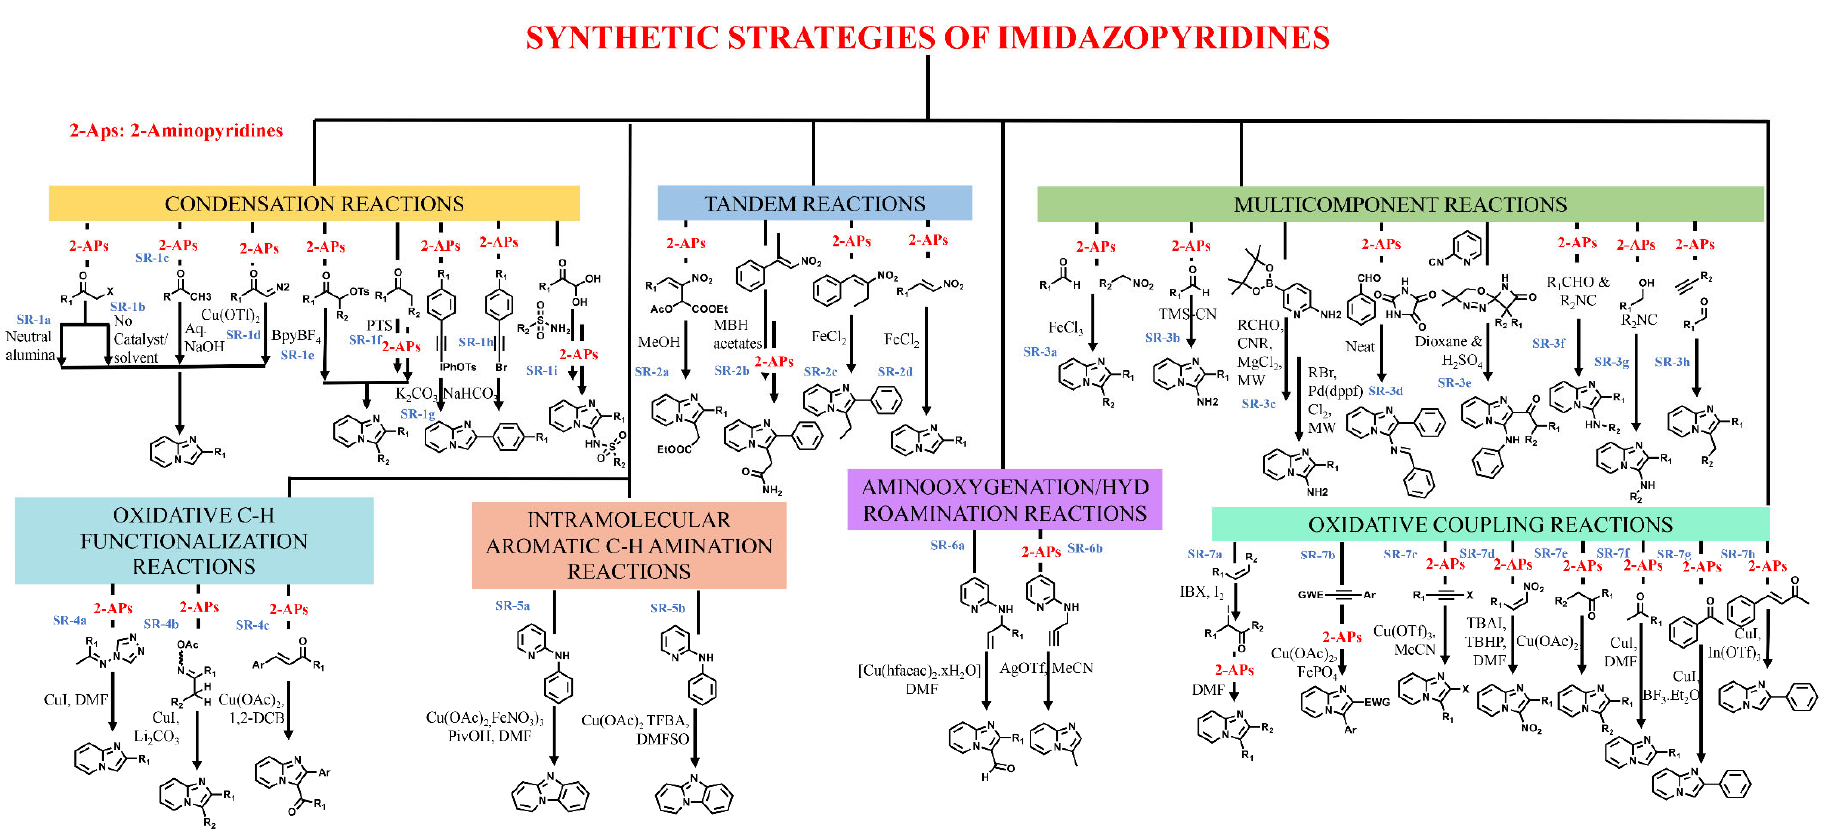
Figure 2. Synthetic strategies for the preparation of imidazopyridines.